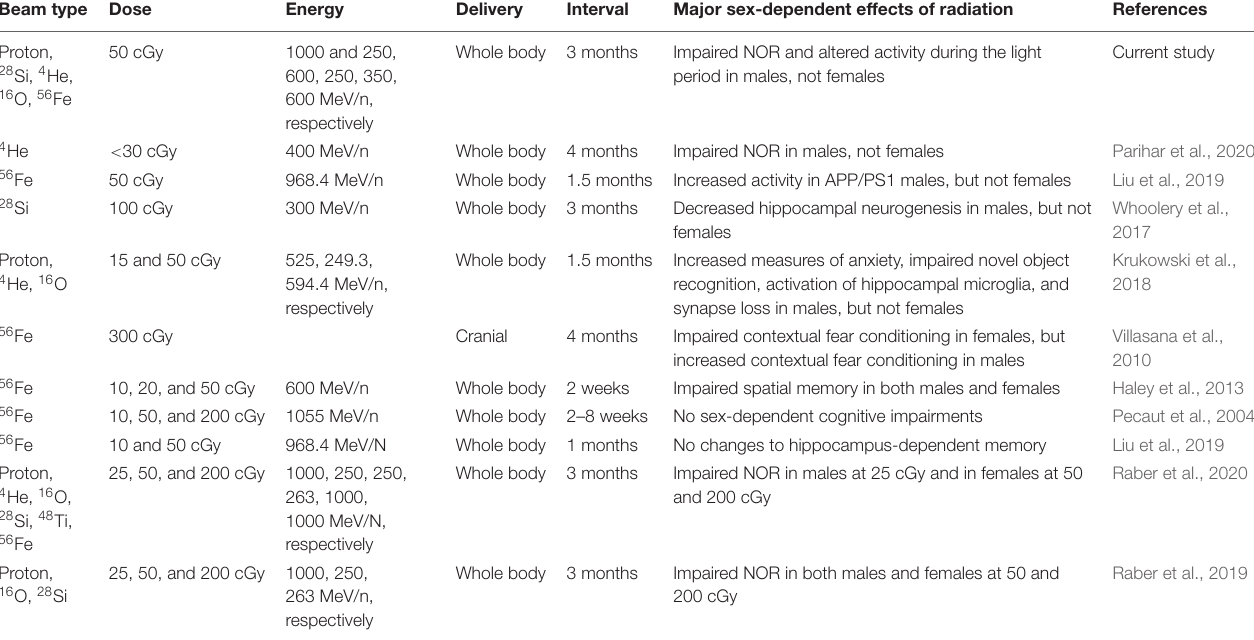
TABLE 3 | Brief overview of the type of radiation, dose, energy, delivery, time delay, and major sex-dependent findings from a selection of previous studies in comparison to the current study. Beam type